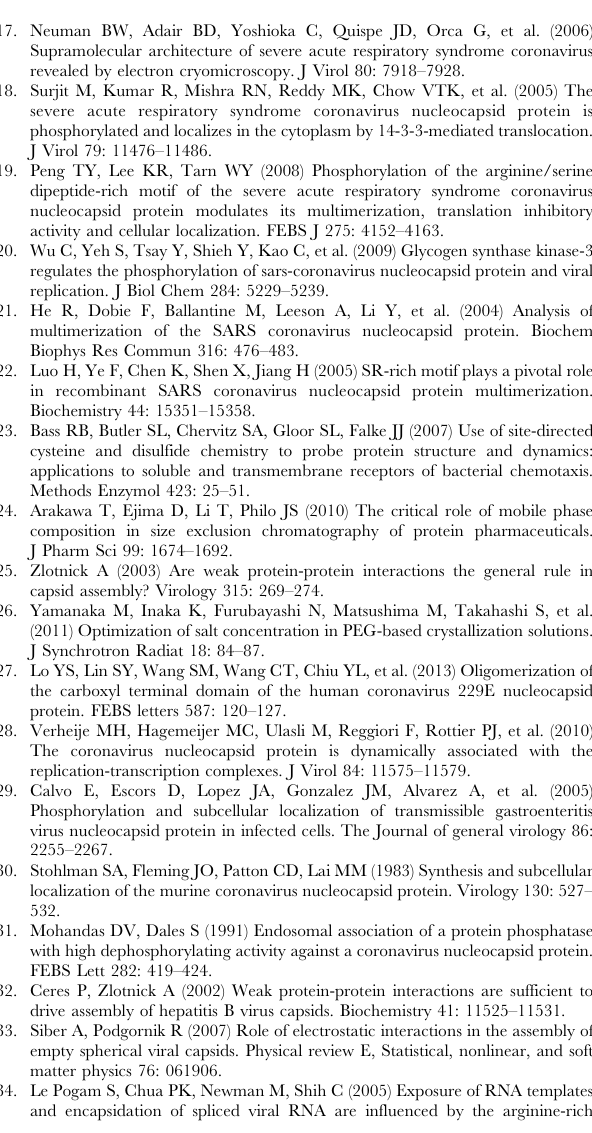
Figure S1 Representative strips from SDS-PAGE of selected DD mutants after disulfide trapping. The arrow denotes the trapped species originating from tetramers or higher order